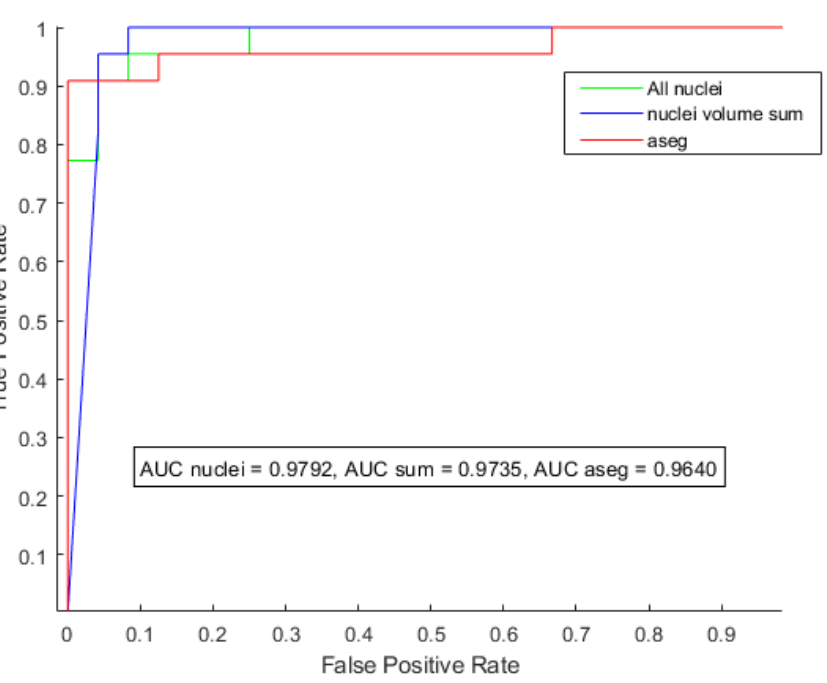
Figure 4. Receiver operating characteristic curves of the three classifiers for a positive diagnosis, predicted vs. actual. Green: the classifier using 25 left–right-averaged normalized thalamic nucleic volumes (Model 1). Blue: the classifier using normalized nucleic volume sum (Model 2). Red: the classifier using total normalized thalamic volume as estimated by the subcortical segmentation pipeline (Model 3).